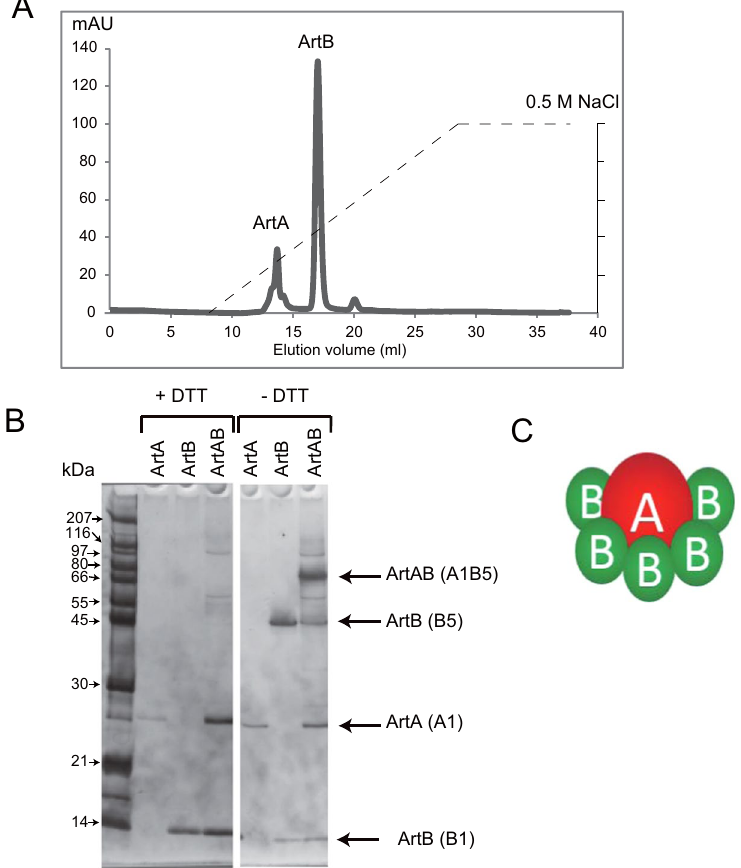
Figure 2. ArtA and pentameric ArtB subunits of ArtAB. ( A ) Separation of ArtA and ArtB by Mono-Q anion exchange chromatography. The dashed line shows the increasing salt gradient (0 to 0.5 M NaCl in 30 mM Tris- HCl, pH 8.8). ( B ) SDS-PAGE analysis of the protein content of the ArtA and ArtB chromatographic fractions obtained by Mono-Q anion exchange chromatography. The gel was stained using a silver staining kit. These along with purified ArtAB were separated by electrophoresis in the presence or absence of 100 mM DTT. Molecular weight standards (kDa) are indicated on the left; positions of the toxin subunits are indicated on the right. ( C ) Schematic illustration of ArtAB subunit structure.